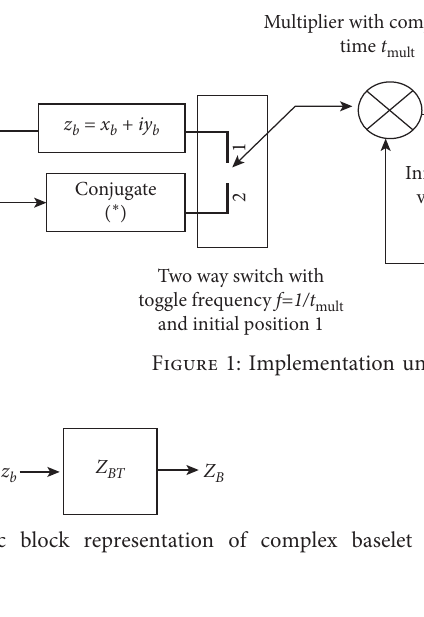
Figure 2: Symbolic block representation of complex baselet